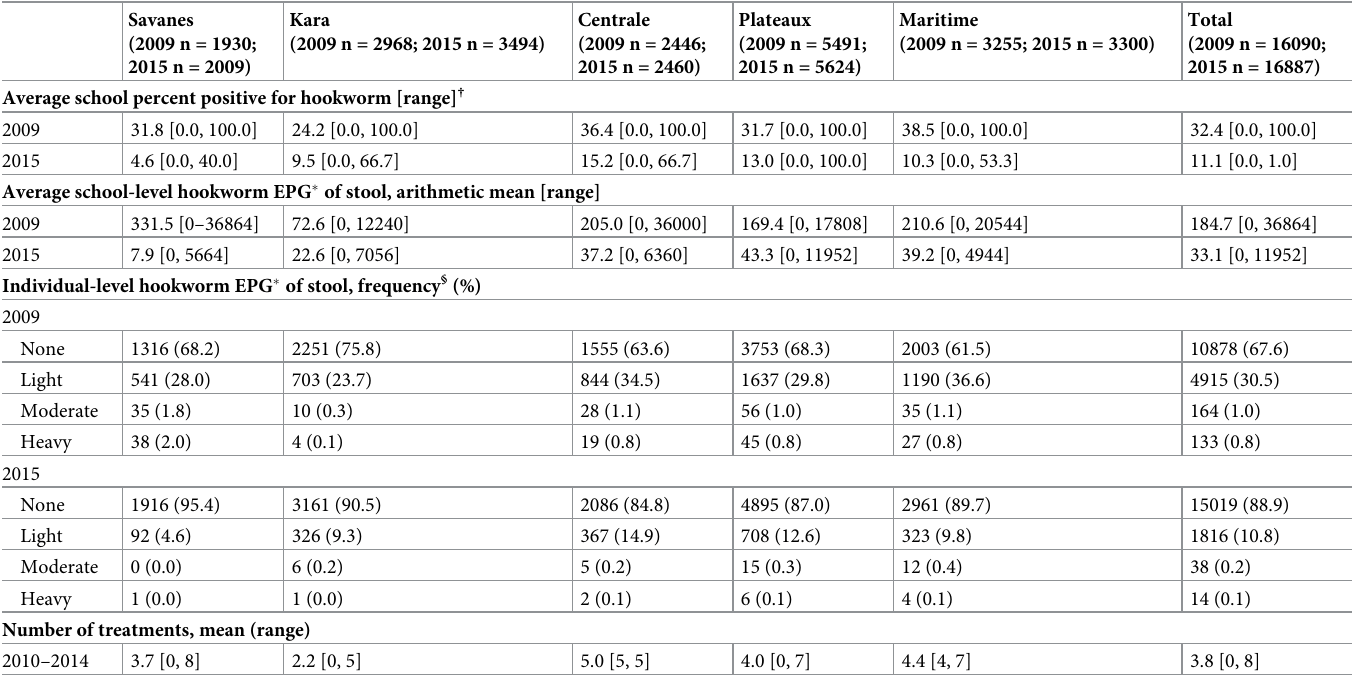
Table 2. Prevalence and intensity of hookworm infections in 2009 and 2015 and number of treatments. Savanes (2009 n = 1930;